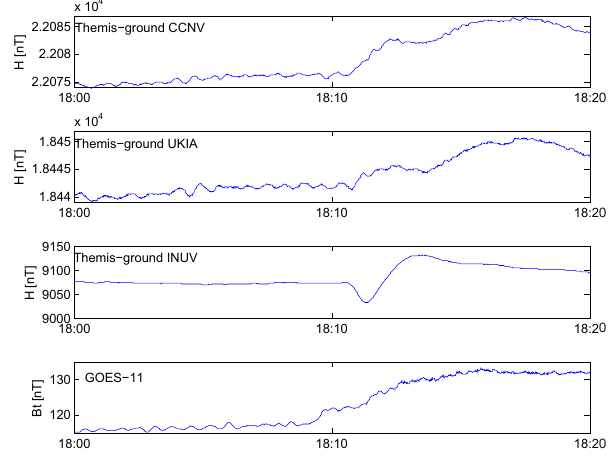
Figure 5. Example of the observations from the low-latitude ground-based magnetometer, 19 November 2007: CCNV (Carson City, geog. lat 39.2, geog. long 240.2,MLT 8.5), UKIA (Ukiah, geog. lat 45.1, geog. long 241.07,MLT 8.25), INUV (Inuvik, geog. lat 68.3, geog. long 226.7,MLT 10.2, and GOES-11 spacecraft inMLT